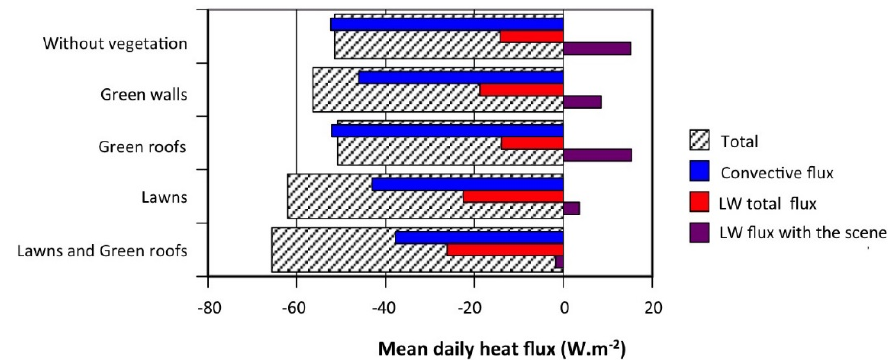
Figure 17. Convective and long-wave (LW) radiative heat fluxes at the external third floor surface, cumulated throughout the day.